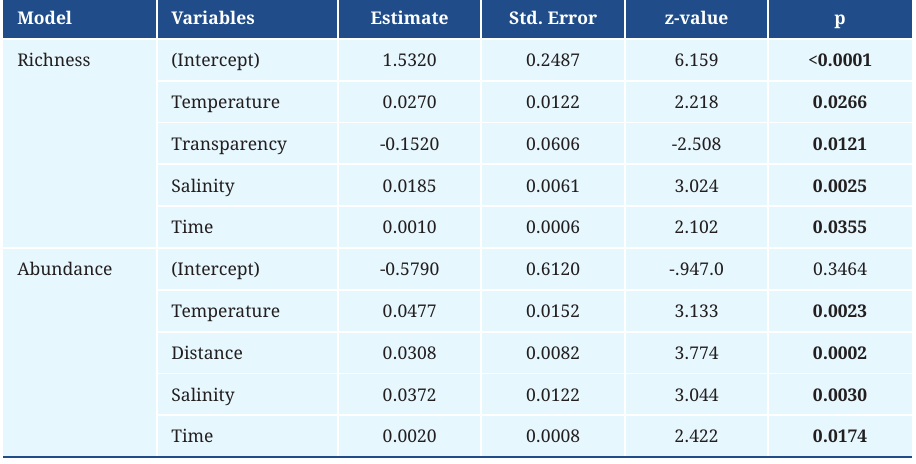
TABLE 2 | Coefficients of the variables of the richness and abundance models. The significance of z-test and error associated to each coefficient are also provided. Significant values are in bold.